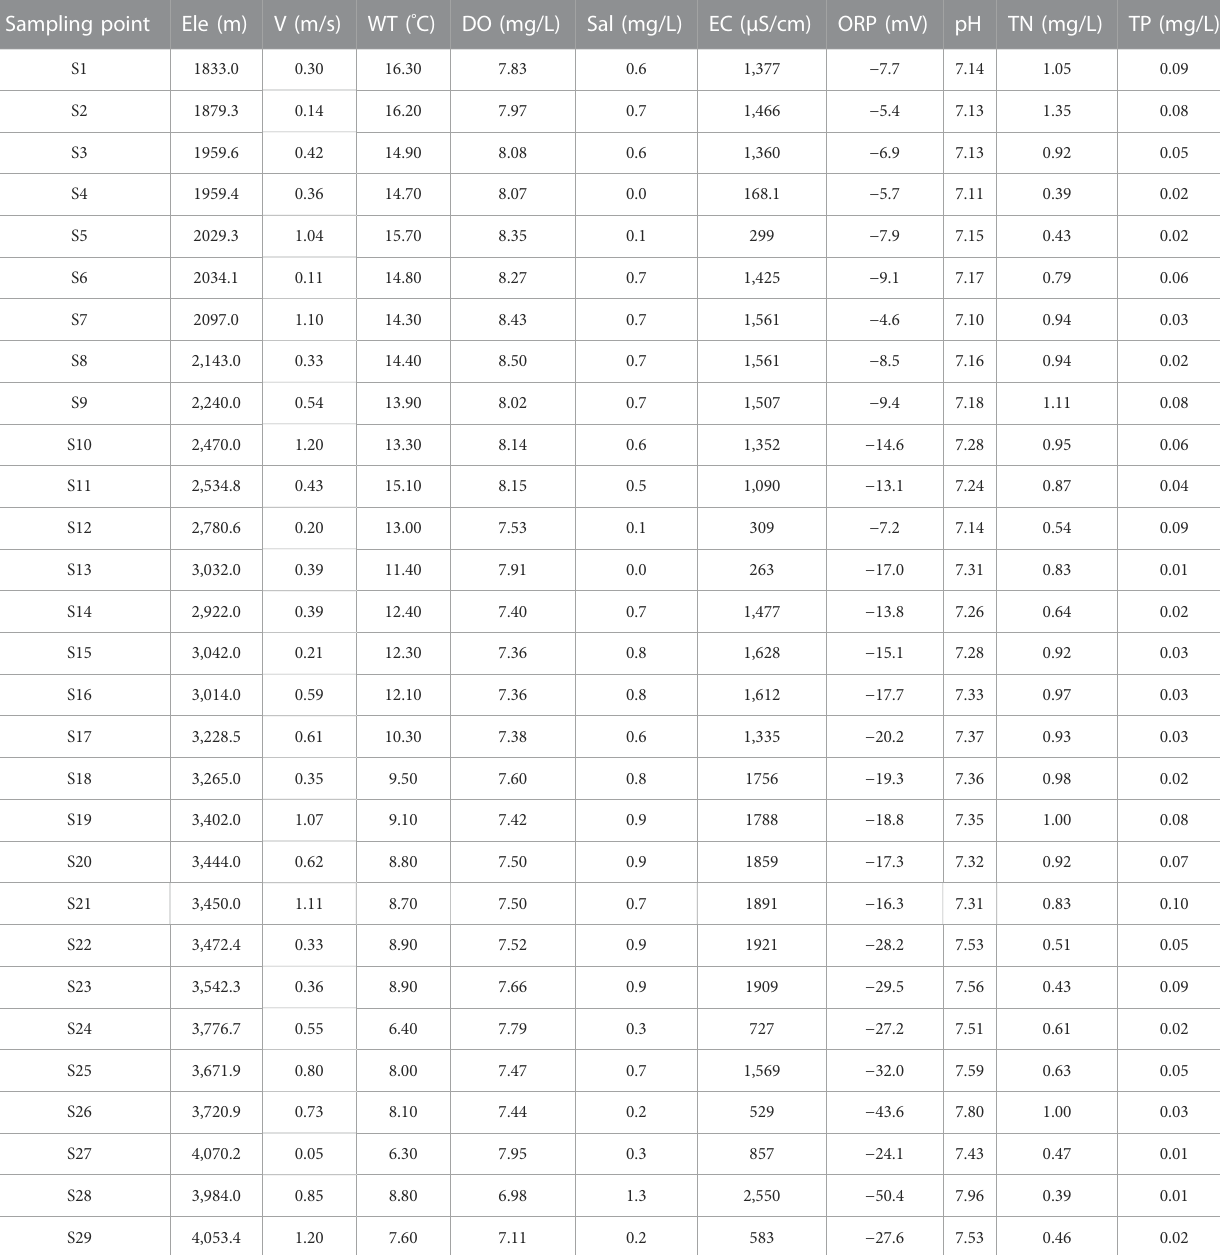
TABLE 1 Physicochemical parameters of water quality at 29 sampling points. Sampling